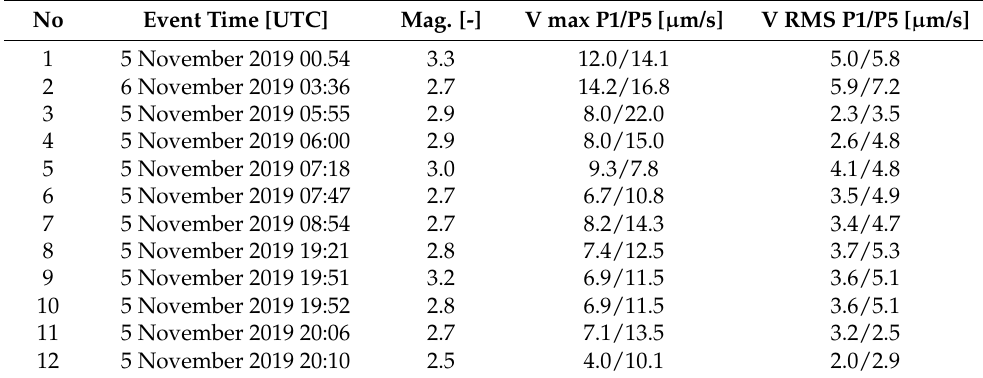
Table 1. Major events of the swarm above LHC alarm level threshold.